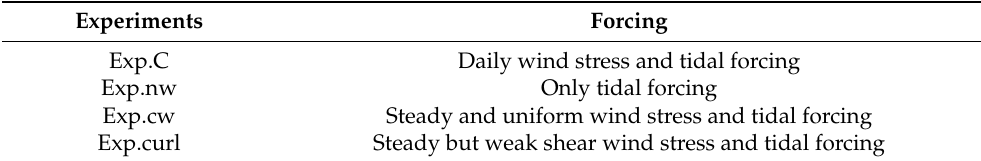
Table 1. List of experiments and